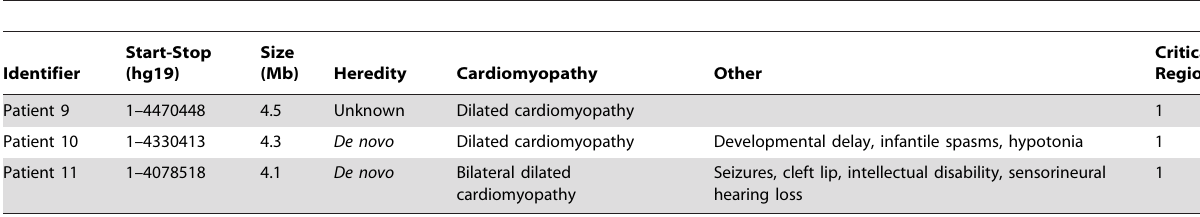
Table 4. Summary of individuals with isolated 1p36 deletions and cardiomyopathy referred to the Medical Genetics Laboratory (MGL) or recruited into a 1p36 research study at Baylor College of Medicine.